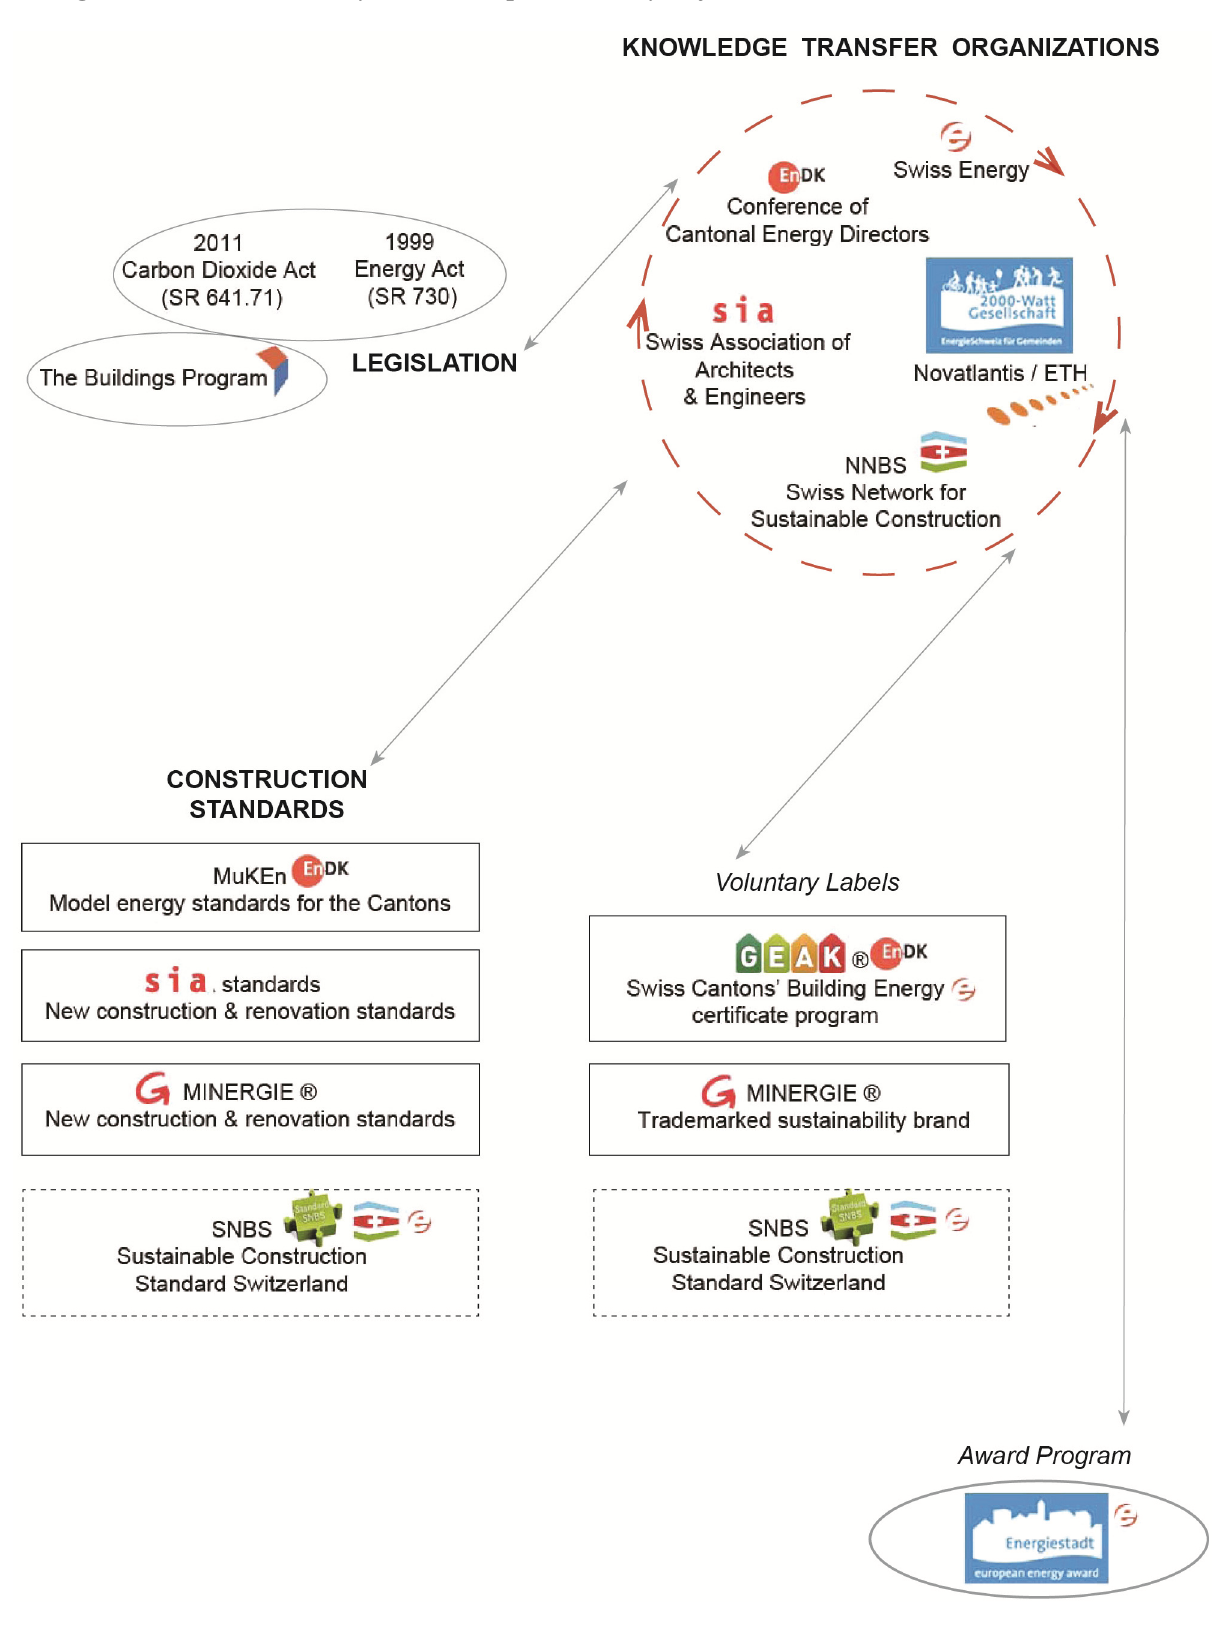
Figure 5. Overview of key relationships: boundary objects linked to sustainable